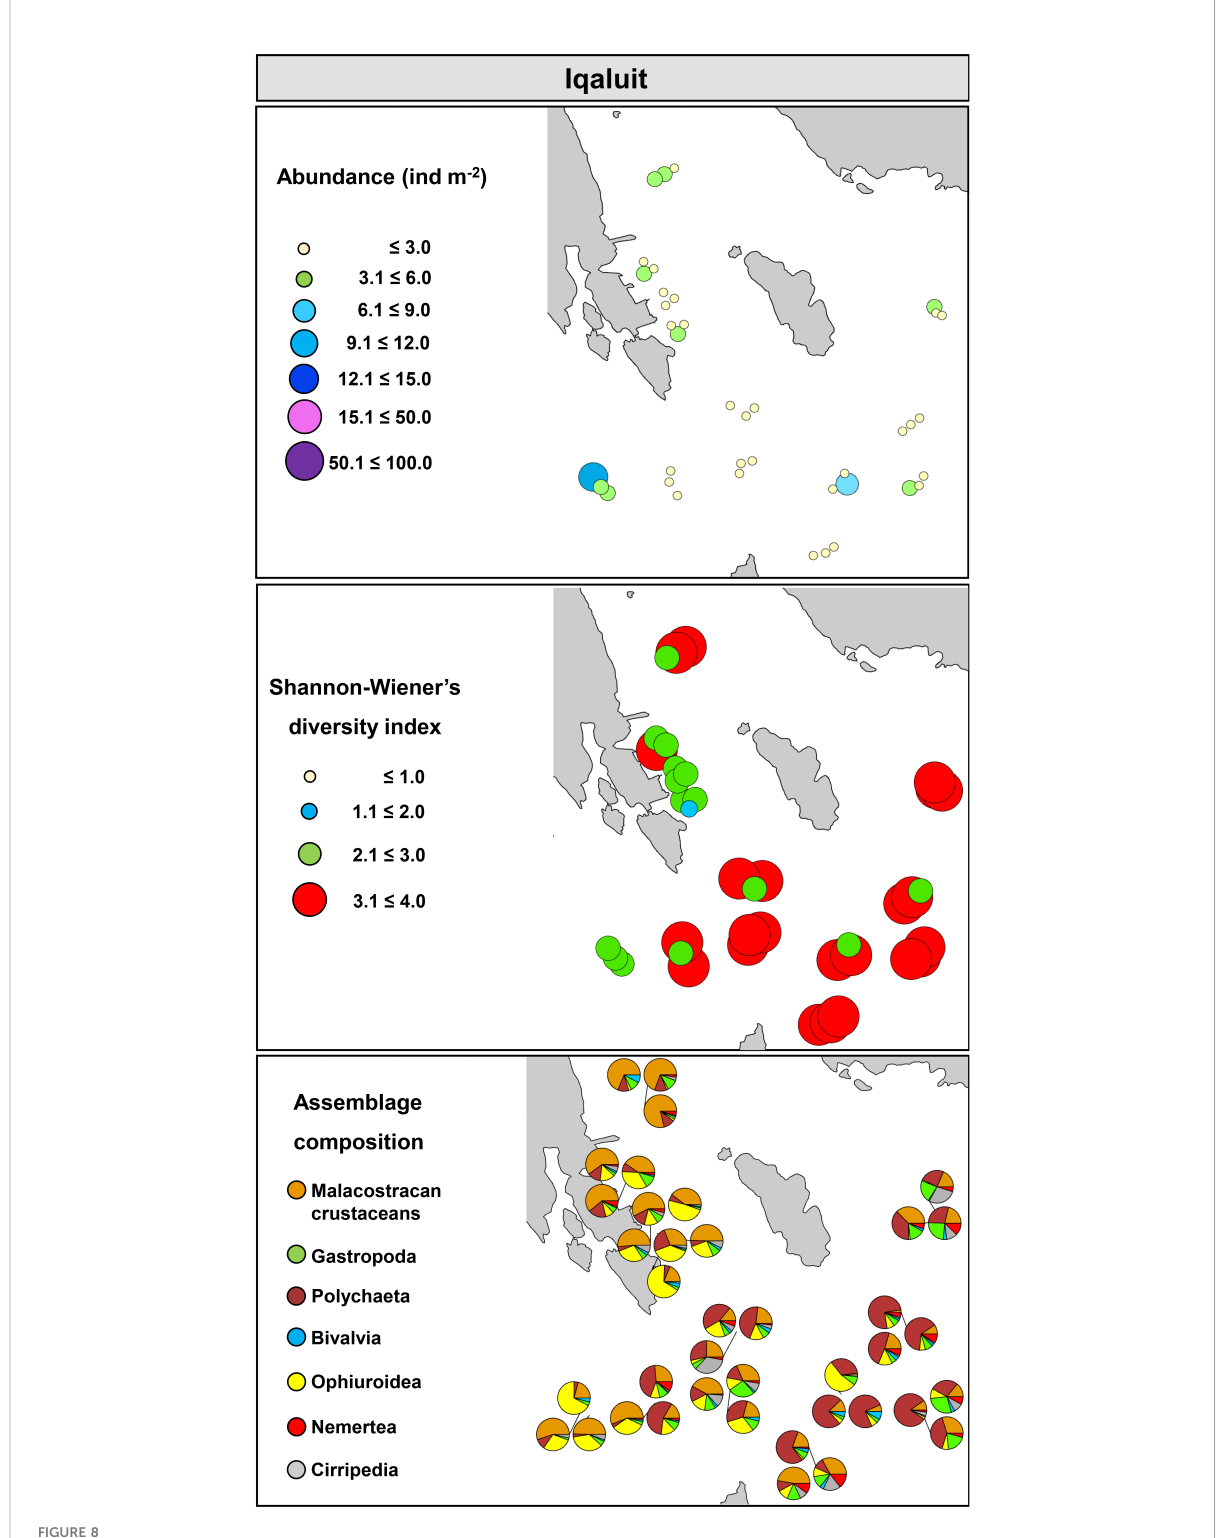
FIGURE 8 Community metrics and assemblage composition in Iqaluit,